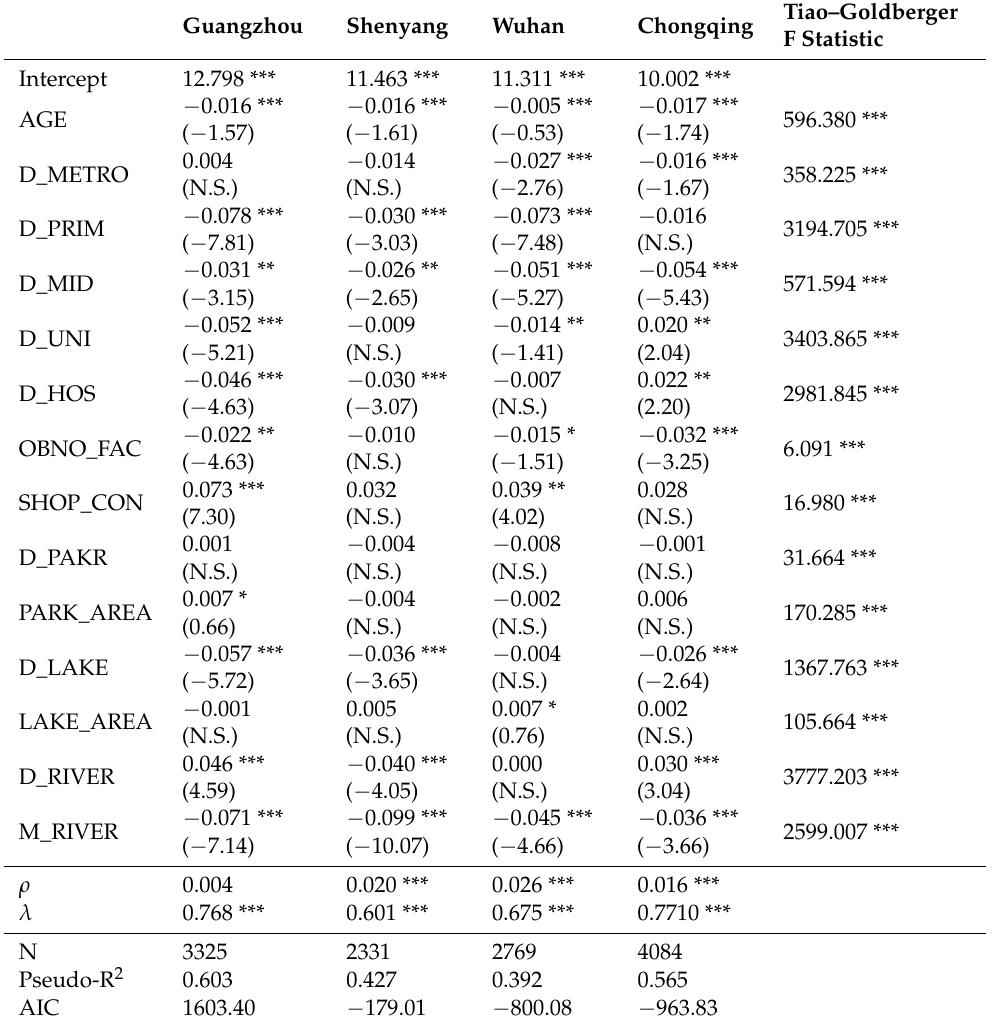
Table 4. SAC estimation and marginal implicit price results for Model